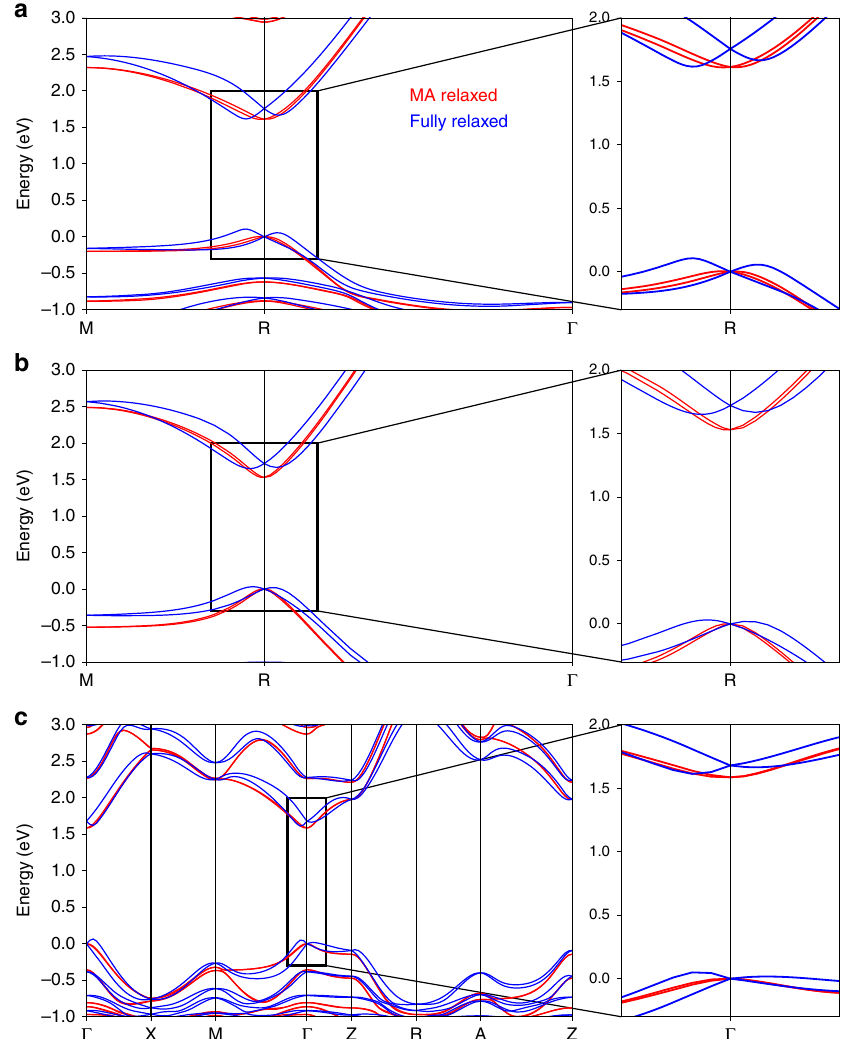
Fig. 3 Structural effects on the bandstructure of MAPbI 3 . Comparisons between the bandstructures of fully relaxed (blue) and MA-relaxed (red) MAPbI 3 structures. In a , b , the bandstructures are shown for single-formula-unit cubic structures with the MA ions aligned in the [100] direction, computed within the LDA ( a ) and HSE ( b ) approximations of DFT. c Bandstructures for a 4-formula-unit tetragonal supercell. The Rashba splitting, which is magni fi ed in the right panel insets, is in all cases much greater in the fully relaxed structures due to the large PbI framework distortions that break inversion symmetry. The k -path labeling of the tetragonal cell is taken from the ref.